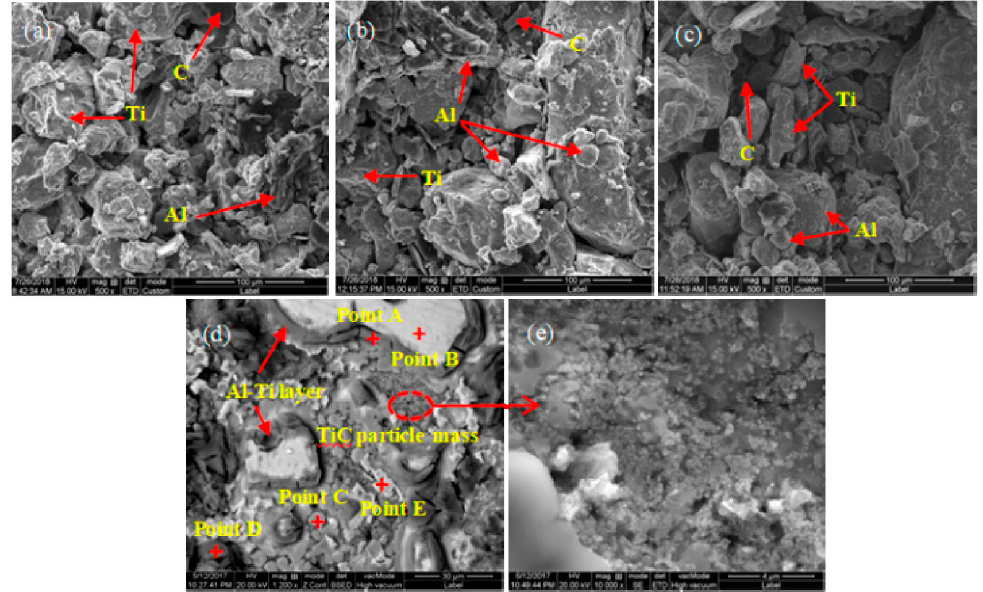
Figure 4. XRD patterns of pressing blocks at 60 s of: ( a ) 2#; ( b ) 3#; ( c ) 4#, and ( d ) 5#.